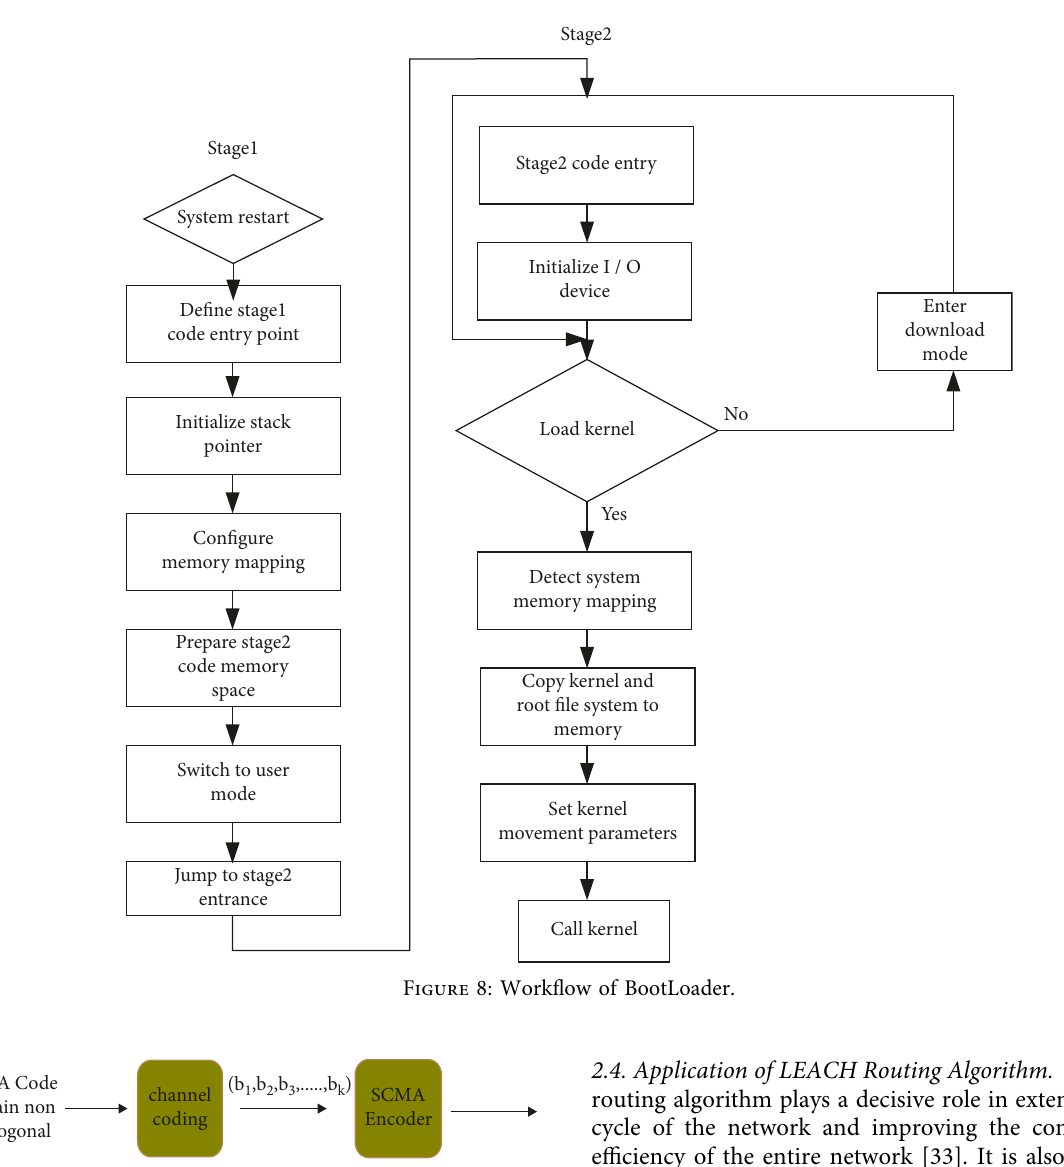
Figure 9: Basic principles of